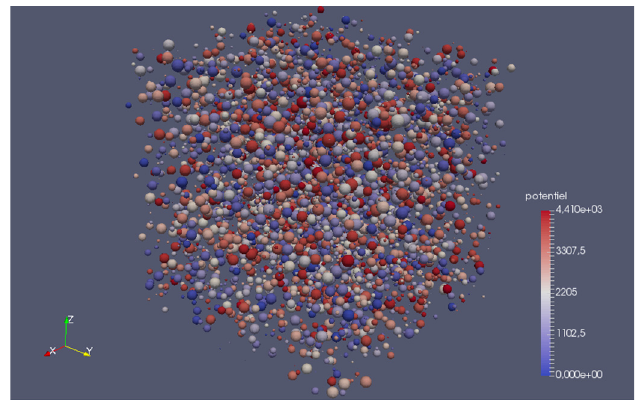
Fig. 2. Simulation of the corner of the glove box with